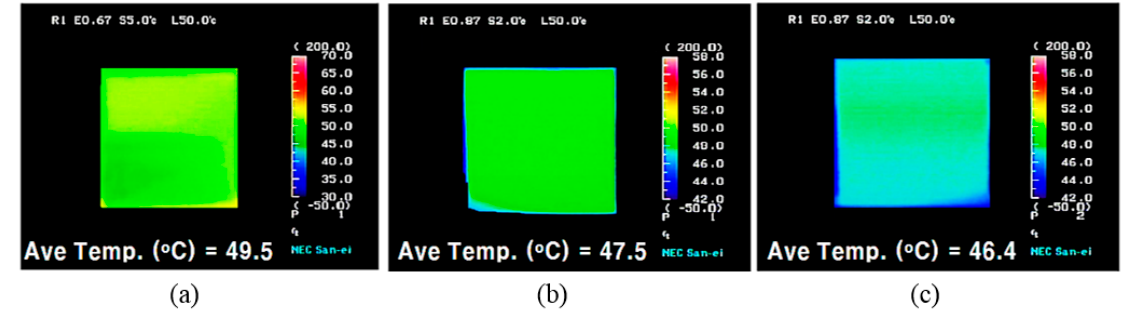
Figure 9. Photographs of the surfaces of the specimens measured by thermal image camera at an atmosphere temperature of 50 °C: ( a ) Uncoated Cu, ( b ) CNT-coated Cu, ( c ) BN-coated Cu.